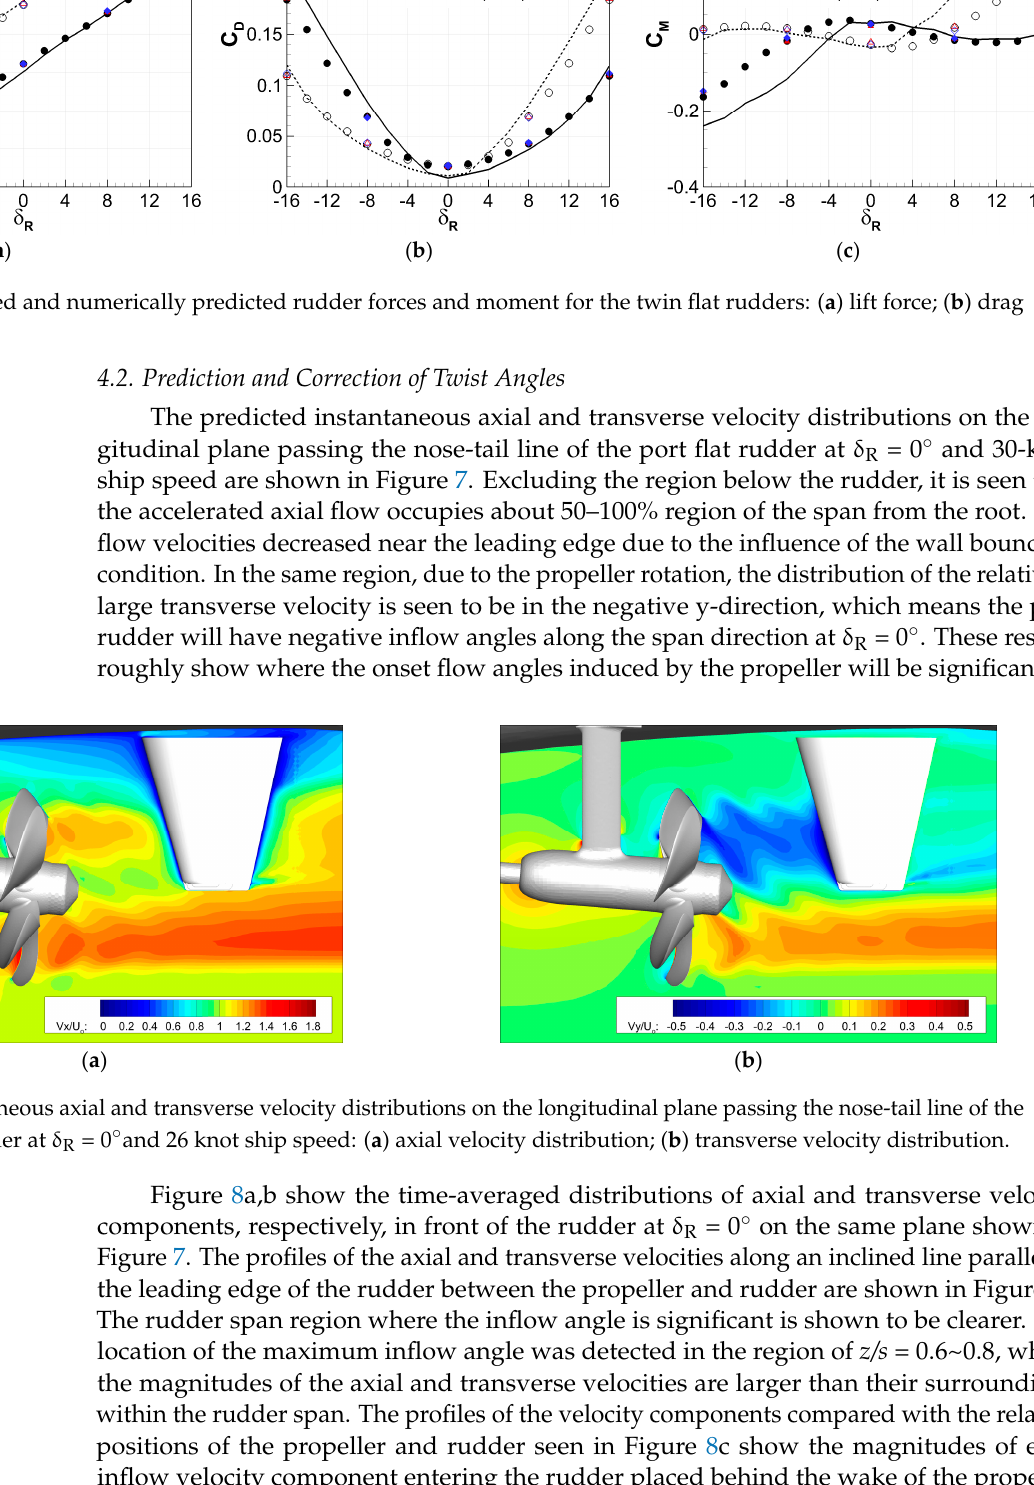
( d ) Figure 5. Experimental observation and numerical prediction of surface cavitation on the twin flat rudders: ( a ) δ R = 0°; ( b ) δ R = − 4°; ( c ) δ R = − 8°; ( d ) δ R = − 12°. 4.1.3. Forces and Moment The measured and predicted lift and drag forces and moment for the flat rudder at 30 knots and cavitating flow condition are shown in Figure 6. The moment was measured with respect to the rudder stock axis that is the center of rotation of the rudder. In Figure 6a, the lift coefficients are seen to linearly change when both starboard and port rudders have no or slight cavitation occurrence. At rudder angles larger than δ R = 8° in absolute value for each side of the twin rudder with significant cavitation, it is seen that the lift forces vary nonlinearly and decrease somewhat because of massive cavitation occurrence. The zero-lift angles are placed at around − 4.69° and 4.91°, respectively, which was due to the inflow angles induced by the propeller. The zero-lift angle can be expected to become around 0° for a twisted rudder applied with appropriate inflow angles. The trend of this measured lift force is closely followed by the current numerical results. The difference between the experimental and numerical results was caused by the limitation of the cur- rent numerical approach where cloud type cavitation occurs as discussed earlier. For each rudder with surface cavitation, the predicted lift forces are smaller than the experimental values because the predicted cavitation was nearly attached to the rudder surface unlike the cloud type cavitation which detached off the rudder surface, as observed in the exper- iment, and increased the suction side pressures. In Figure 6b,c, similar trends are also seen